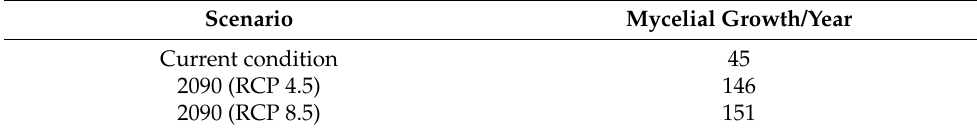
Table 8. Annual mycelium growth for the different climate scenarios examined.